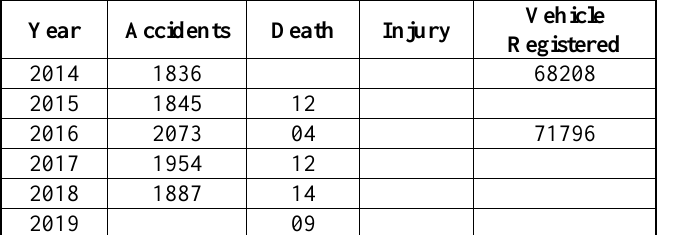
Table 14: Data on Accidents and Road Fatalities.